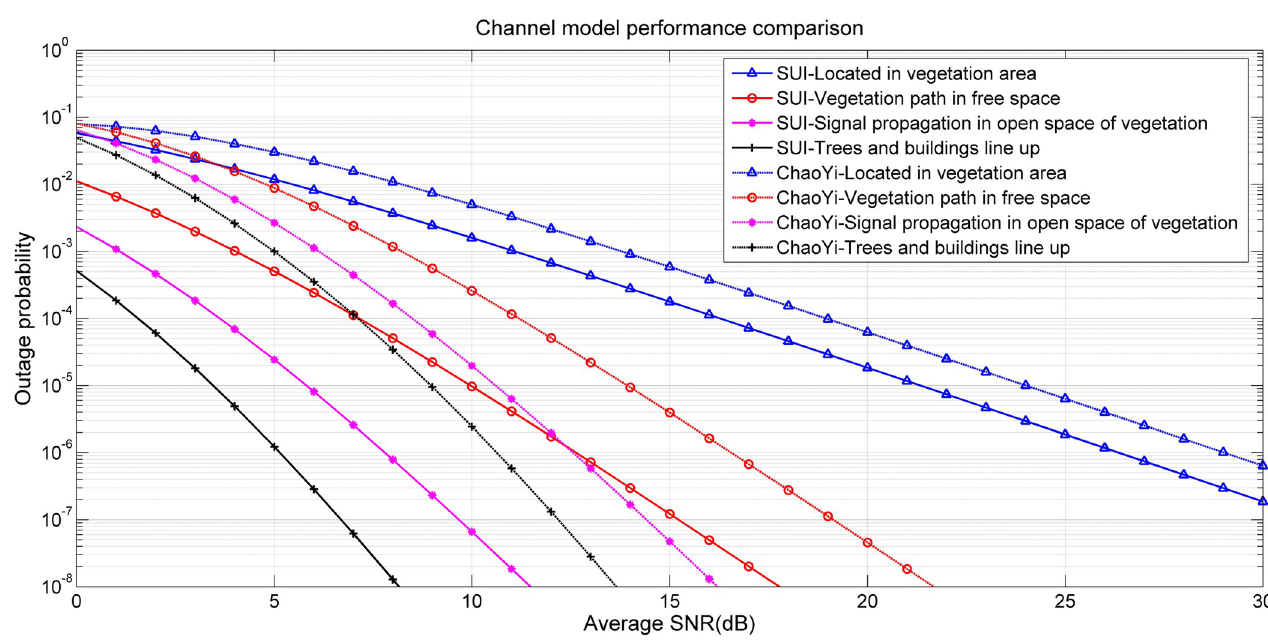
Fig 15. Channel model performance